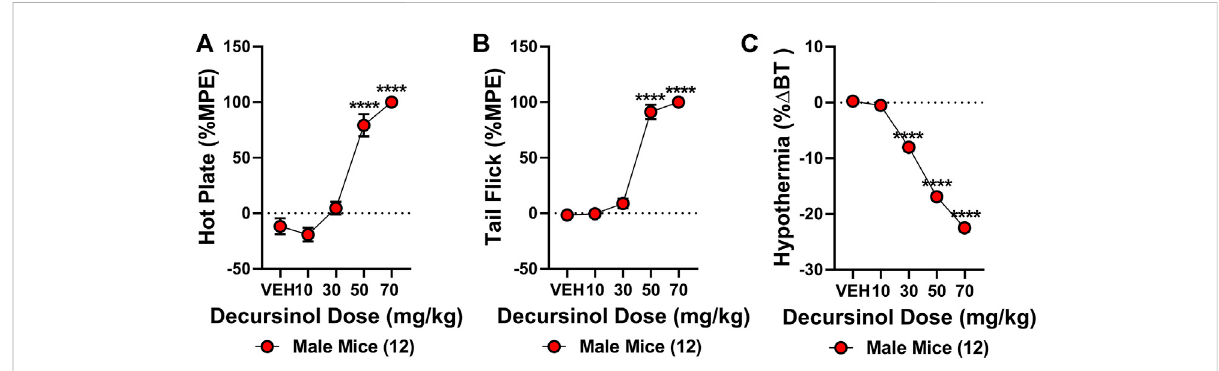
FIGURE 2 Decursinol-induced antinociception and hypothermia. Cumulative dose-response curves were generated using male mice (N = 12) to assess the antinociceptive and hypothermic effects of vehicle (VEH), 10, 30, 50, and 70 mg/kg decursinol in the hot plate (A) , tail- fl ick (B) , and hypothermia (C) assays. Mice were injected with increasing doses of decursinol and assessed for antinociception (%MPE) and hypothermia (% Δ BT) 30 min later. Error bars represent the mean ± SEM. Data were analyzed using repeated measures (RM) one-way ANOVAs and Bonferroni post hoc tests. (**** p < 0.0001 compared to VEH).